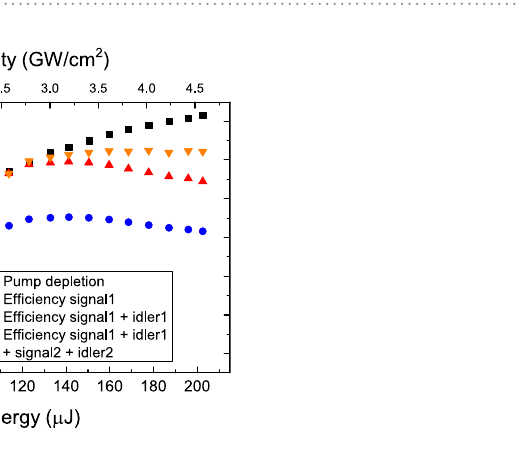
Figure 4. Conversion efficiencies and pump depletion. Pump depletion, s1 efficiency and combined signal-and- idler efficiencies for the two MOPO cascade